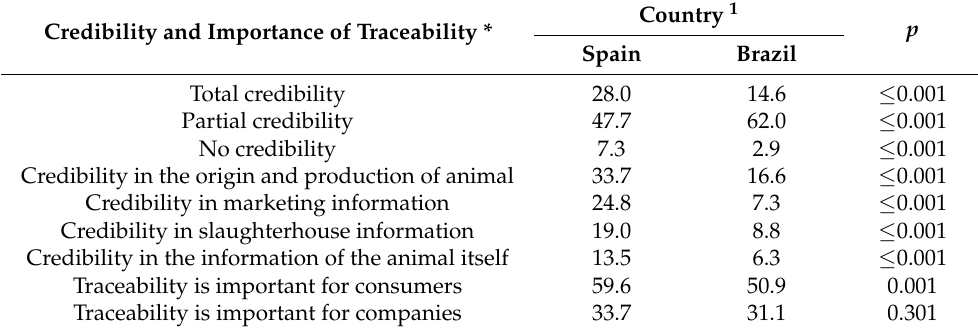
Table 3. Credibility and importance in the traceability information that Spanish and Brazilian consumers believe is appropriate to their way of